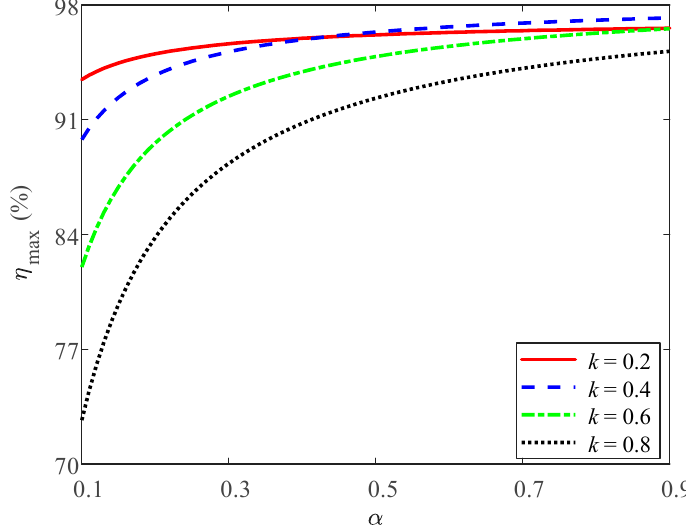
Figure 4. The maximum efficiency varying with α .